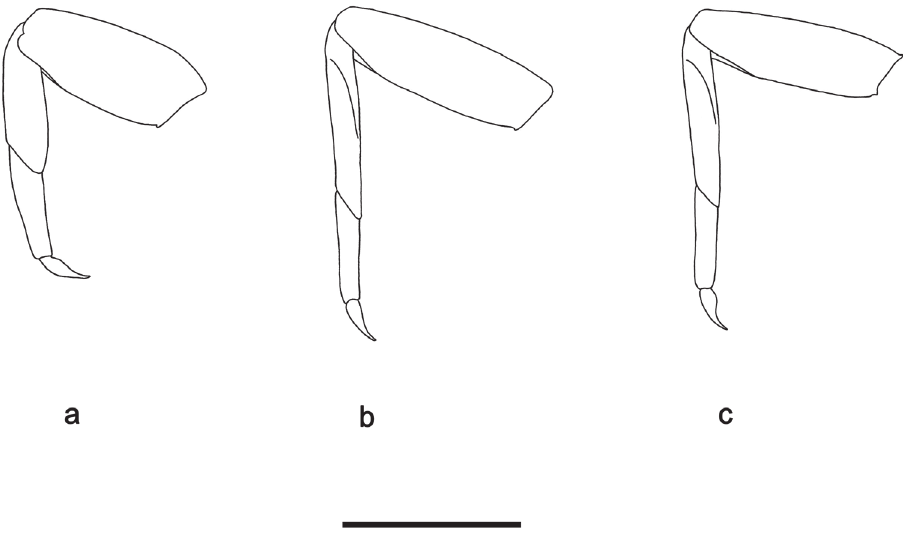
Figure 6. Pedicelliops capillifer gen. et sp. nov., larva morphology: a foreleg b middle leg c hind leg. Scale bar: 0.5